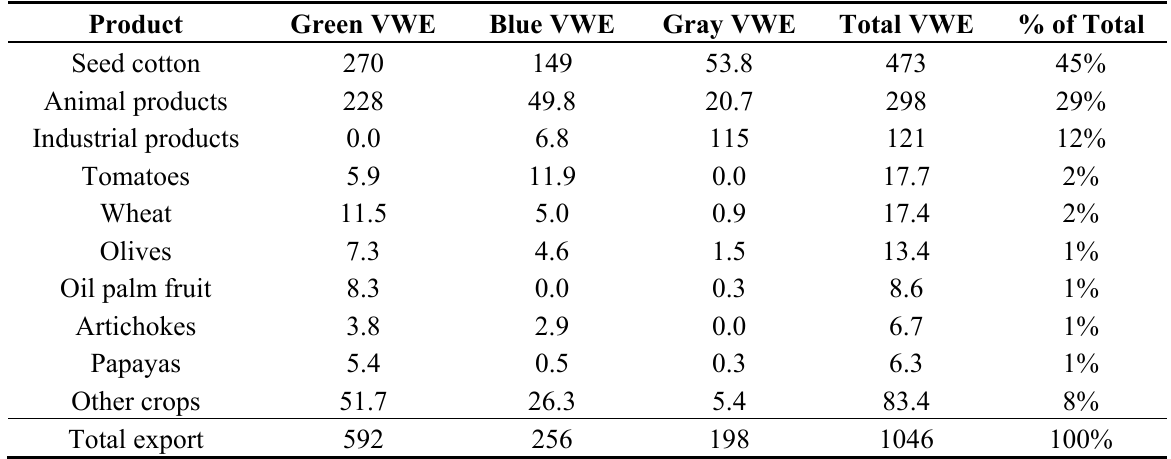
Table 2. Jordan’s virtual water export (VWE) by product category (10 6 m³/year). Period: 1996–2005. Data based on